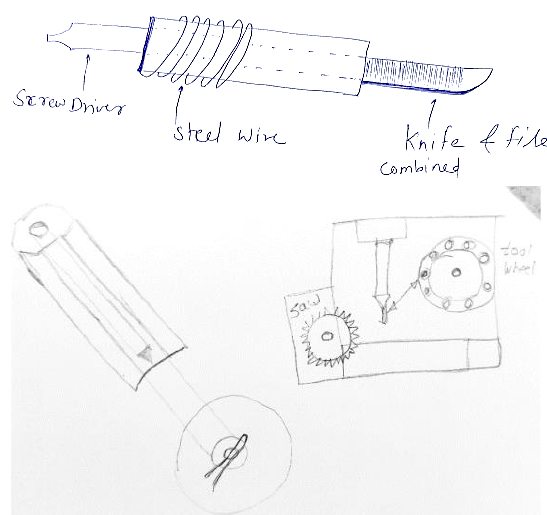
Fig. 2: Sample concepts produced by students The participants completed three self-reported surveys reporting their perception of curiosity, perseverance, and diligence. First, participants completed the Five-Dimensional Curiosity